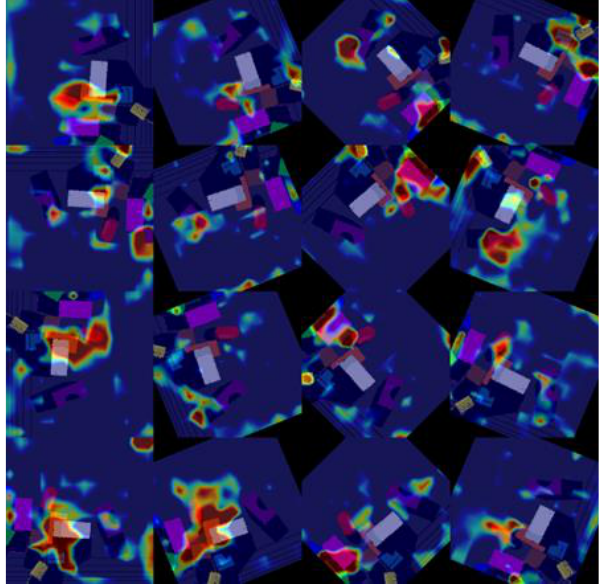
Figure 9. Heatmap visualizations of pixel-wise maps of Q-values generated against 16 rotations of an RGB-D heightmap at 22.5 degrees.